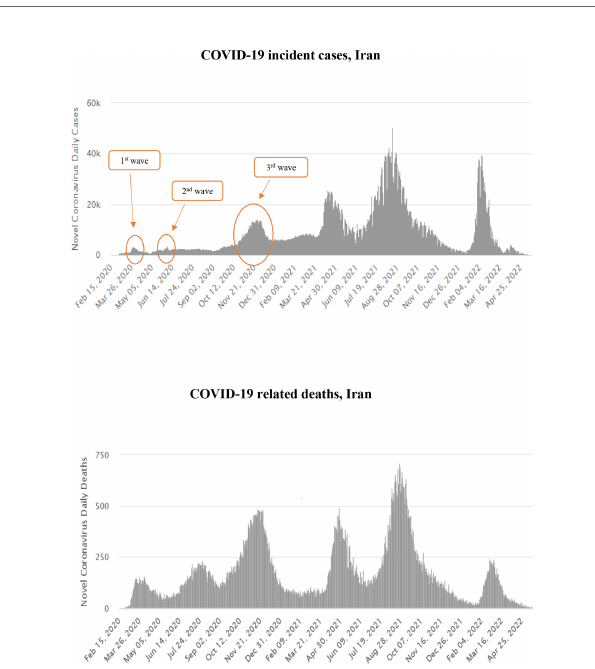
FIGURE 2 | Flowchart with inclusion/exclusion criteria of hospitalized COVID- 19 patients enrolled in this study from October 22, 2020 – January 7, 2021.